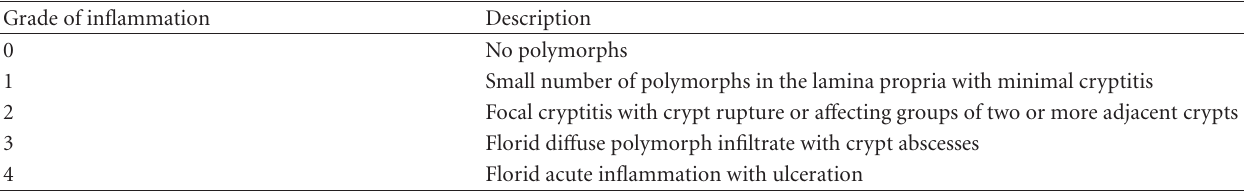
Table 1: Histological grade of inflammation. The histological grade of inflammation present in biopsies taken from the most inflamed area of the rectosigmoid region at sigmoidoscopy, adapted by GTW for Crohn’s colitis from the system described by Truelove and Richards [24] for ulcerative colitis.